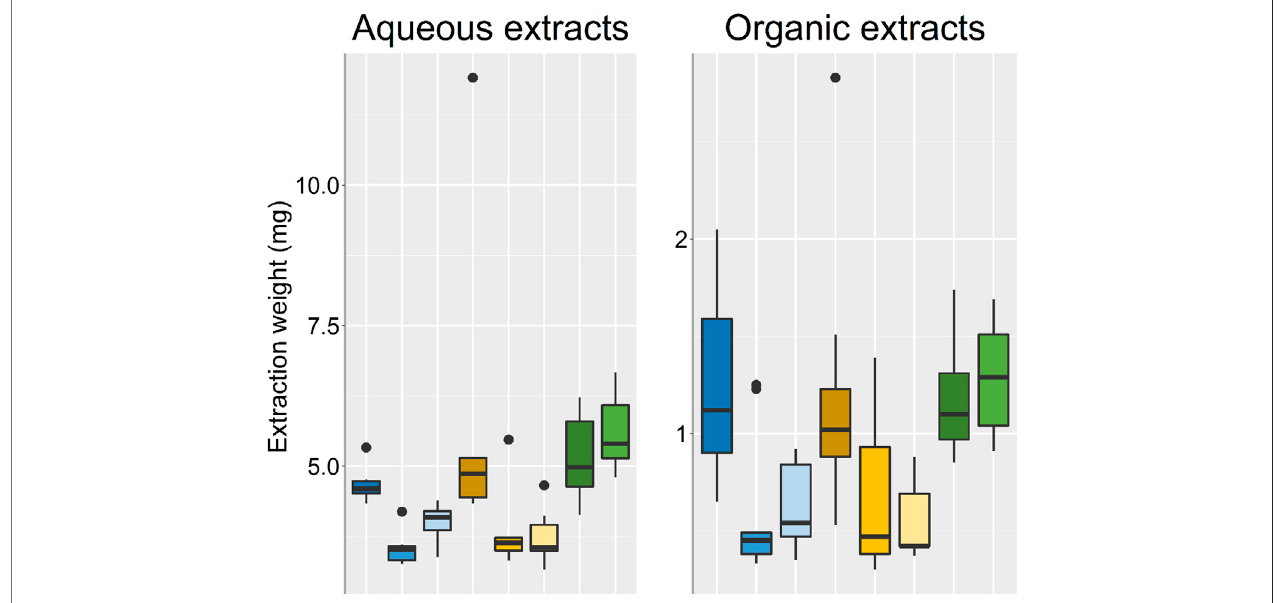
FIGURE2| Boxplotsovertherespectiveextractionweightsforeachsamplegroup,outliersaredenotedbydots.EtOHextr.1(darkblue ),EtOHextr.2(blue ), EtOH sp. (light blue ), MeOH extr.1 (dark orange ), MeOH extr.2 (yellow ), MeOH sp. (light yellow ), frozen (dark green ), and fl ash frozen (green ).